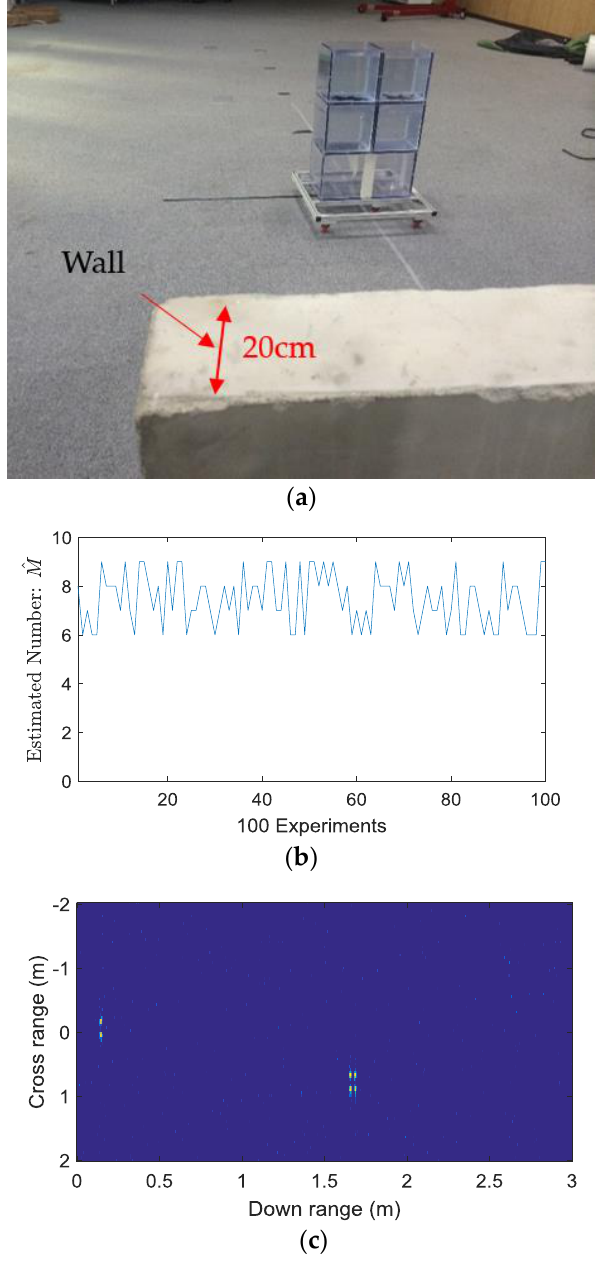
Figure 11. ( a ) Imaged indoor scene, ( b ) Value of M obtained by MDL through 100 experiment trials; ( c ) One frame of the detection results obtained when 𝑀̂ = 6.